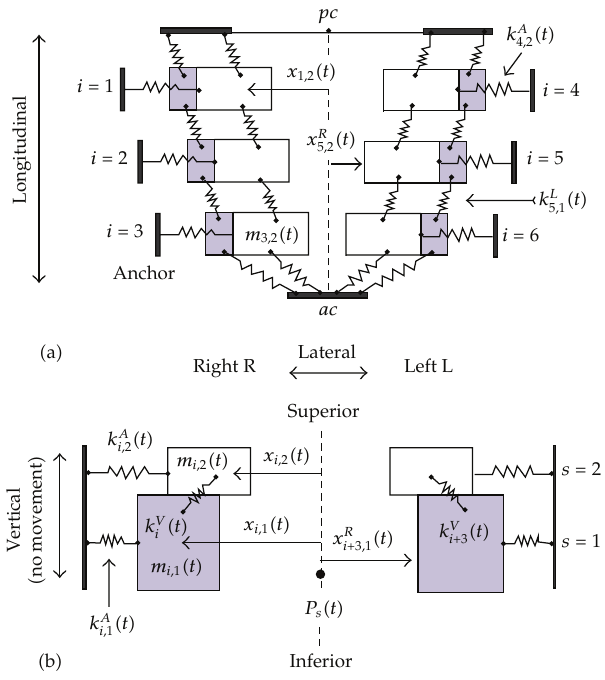
Figure 9: Multimass model of the vocal folds (cid:4) 51 (cid:5)